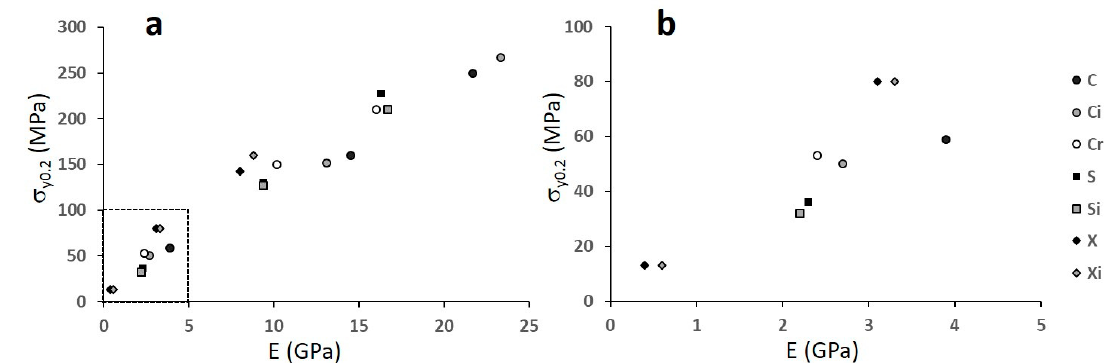
Figure 14. Yield strength versus Youngs modulus; the graph ( b ) is an enlarged inset of the dashed area in the graph ( a ). The letters refer to structures.